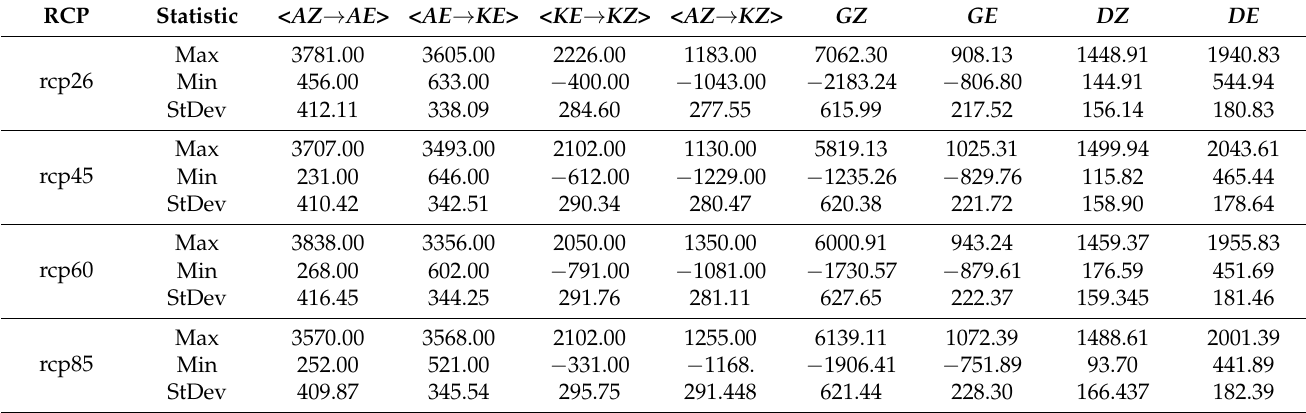
Table 2. Energy conversion, generation and dissipation terms. Units are in 10 − 3 Wm − 2 .